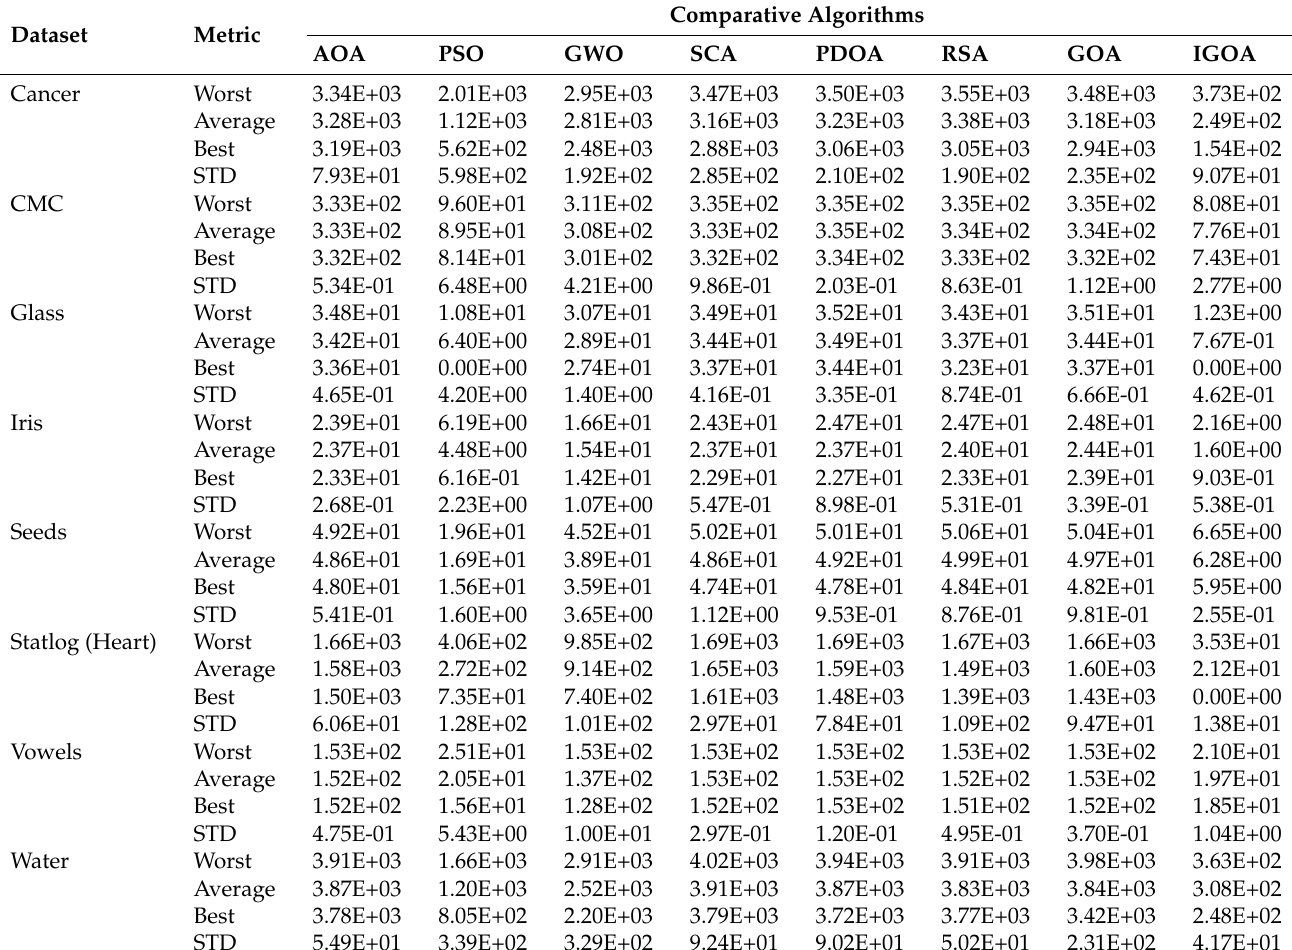
Table 13. The obtained results by the comparative methods using the data clustering problems.